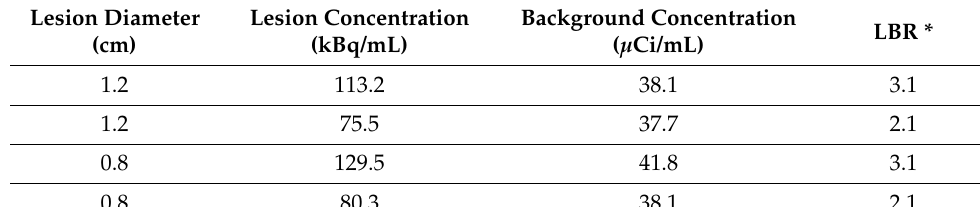
Table 2. Activity concentrations used in SNR phantom experiments. * Lesion-to-Background Ratio. Lesion Concentration Lesion Diameter (cm) (kBq/mL)